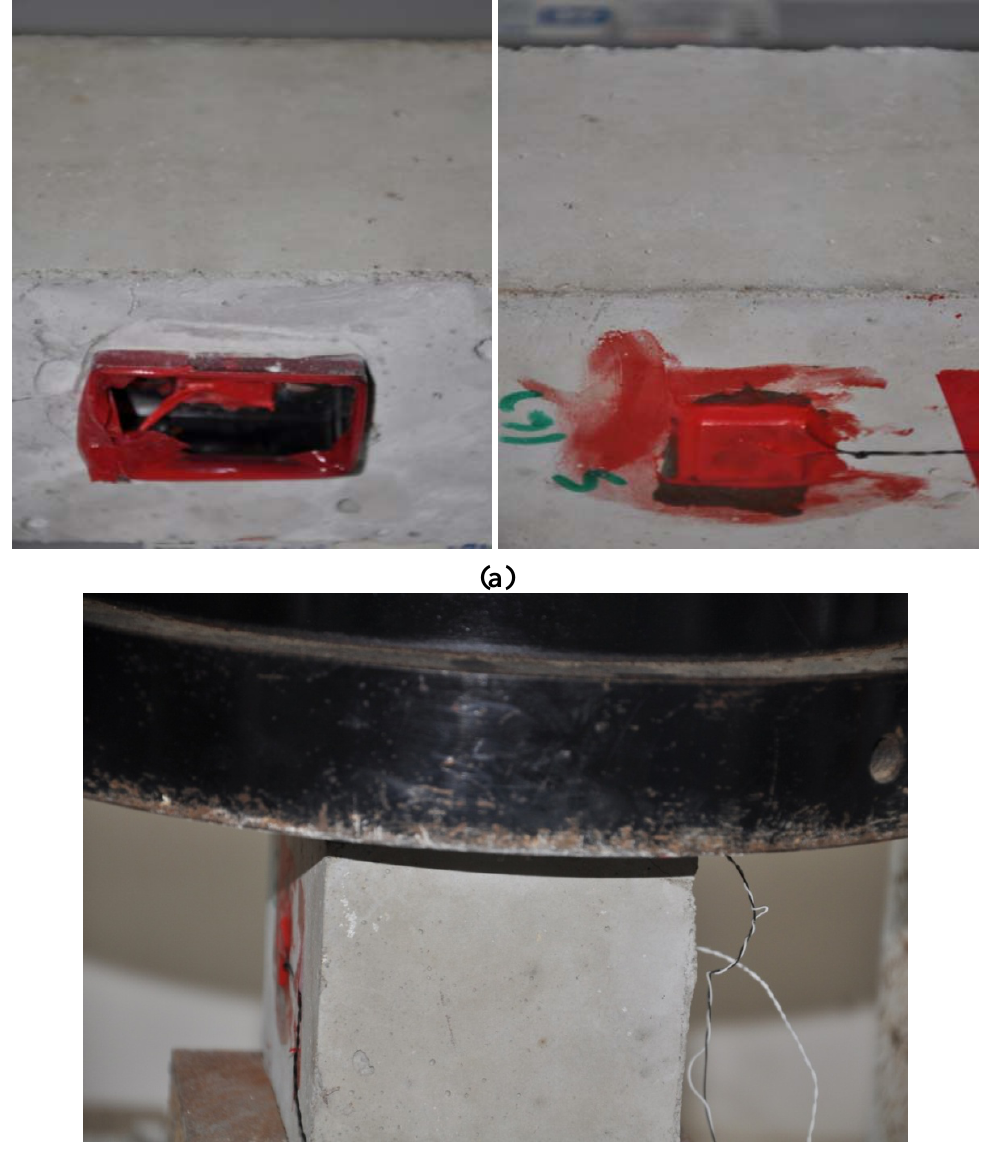
Figure 4. (a) Reusable PZT transducer and surface bonded PZT transducer, (b) 100 mm cube sample under on hold